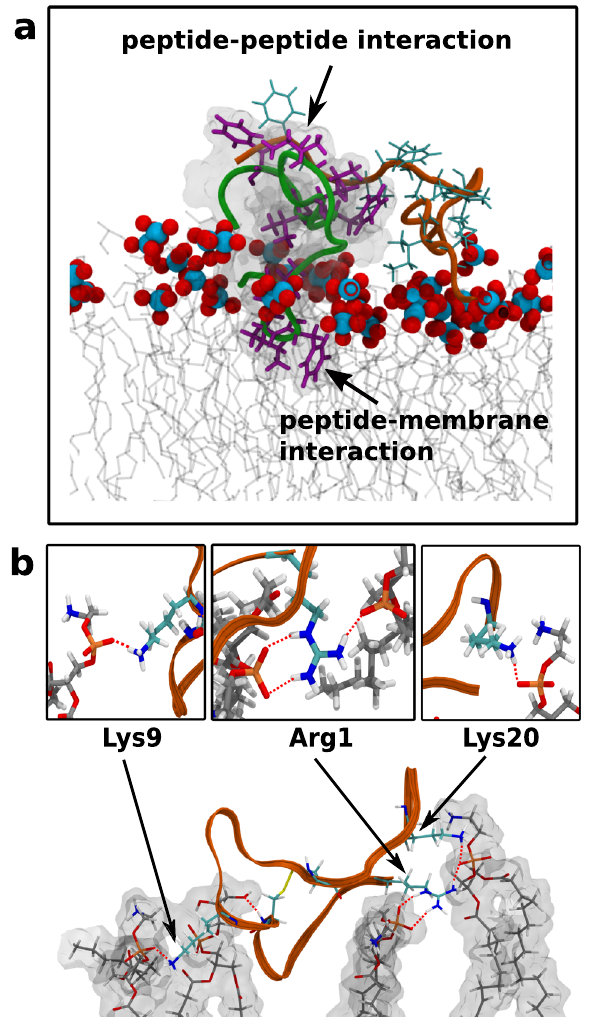
Fig. 9 Observed peptide-membrane interactions. a Hydrophobic residues involved in peptide-peptide and peptide-membrane interactions. Two peptides (in green and orange ribbon) and their respective hydrophobic residues are depicted (in magenta and cyan sticks). Blue-red balls denote lipid phosphate groups, while the acyl chains are depicted in gray lines. b Polar interactions between HSEP3 peptide (ribbon in orange) and the membrane lipids (sticks) as observed in the fi nal snapshot of simulation. The h-bond interactions (red line, dotted) are chie fl y mediated by the cationic residues — lysine and arginine.